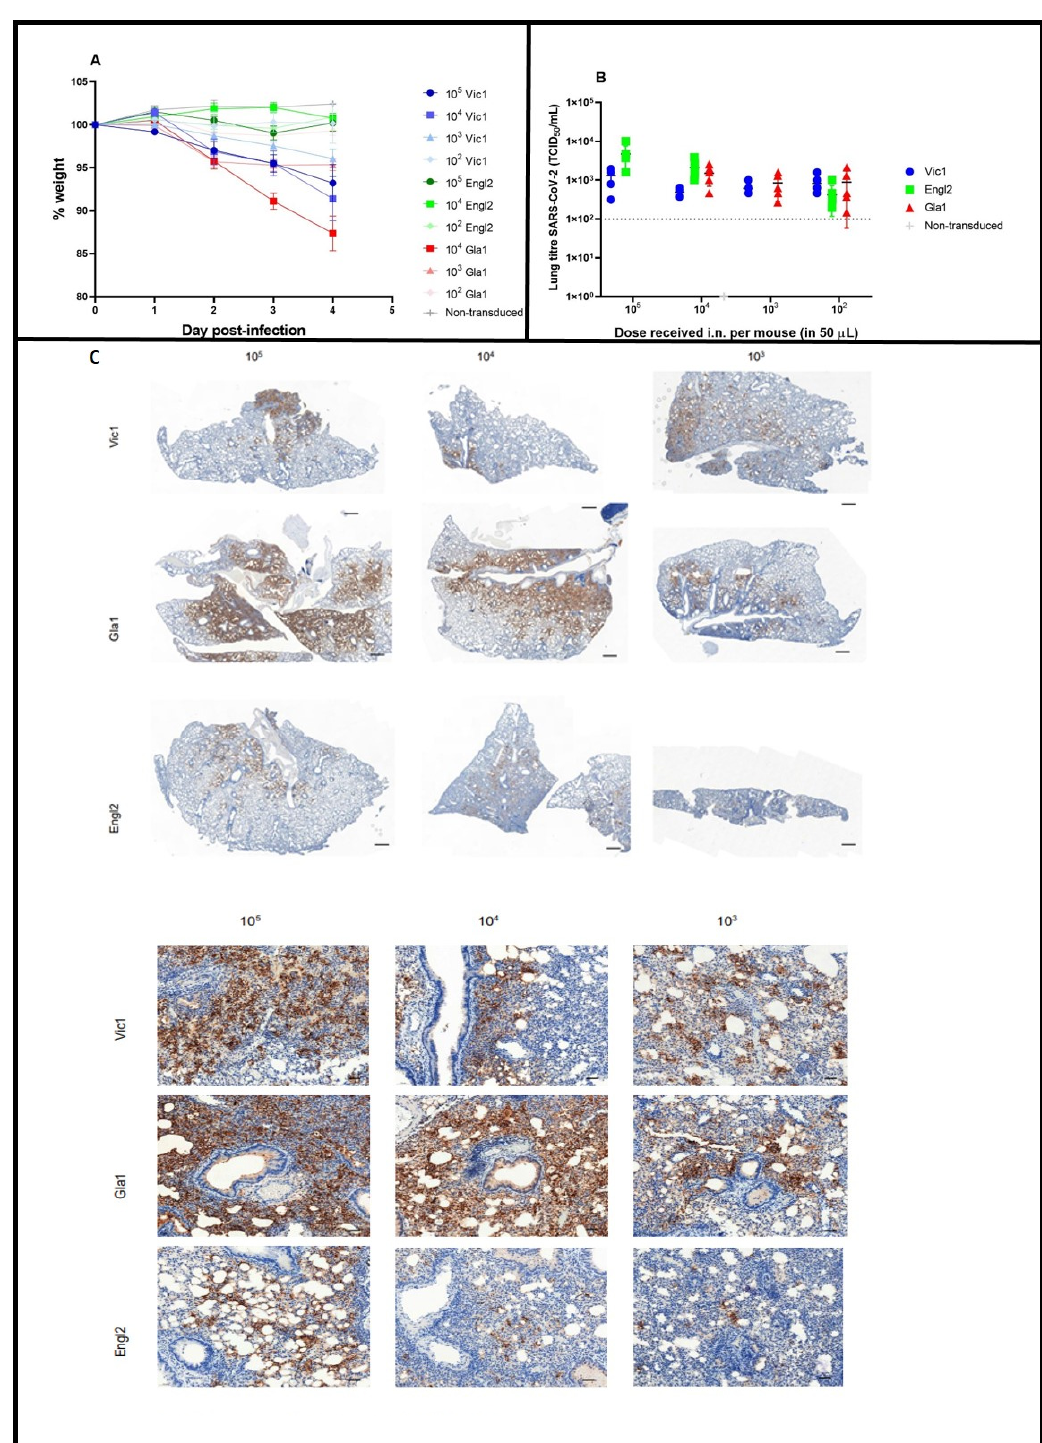
Figure 2. Variation in weight change, lung titres and presence of viral nucleoprotein at day 4 post- infection after challenge with different doses and strains of SARS-CoV-2. Groups of five or six mice were transduced with Ad5-CMV-hACE2 and five days later infected with the indicated dose-level (TCID 50 in 50 µ L i.n.) of SARS-CoV-2 Vic1 (blue symbols and lines), Engl2 (green symbols and